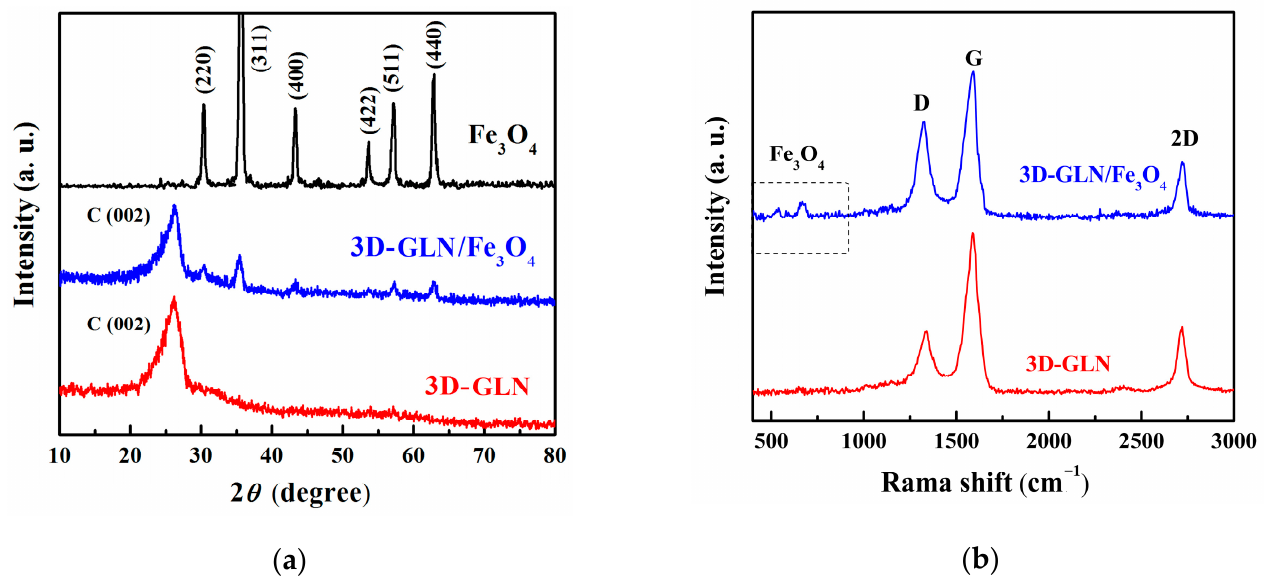
Figure 1. ( a ) XRD patterns of 3D-GLN, 3D-GLN/Fe 3 O 4 , and pure Fe 3 O 4 , ( b ) Raman spectra of 3D-GLN and 3D-GLN/Fe 3 O 4 .